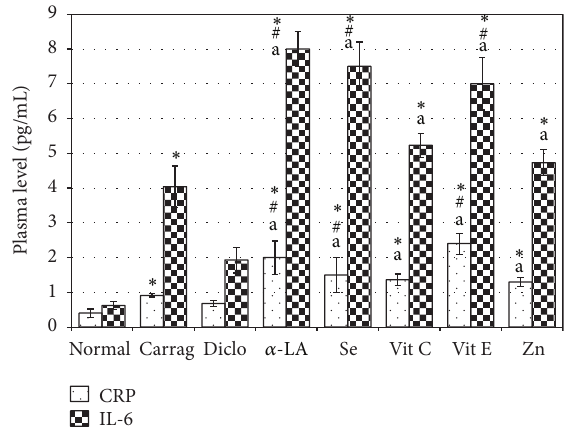
Figure 1: Effect of treatments on plasma CRP and IL-6 levels.All rats were provided daily oral doses of diclofenac (5 mg/kg), selenite (2.5 mg/kg), Vit C (1g/kg), Vit E (300mg/kg), or ZnSO 4 (25 mg/kg); 𝛼 -LA (50 mg/kg) was administered IP. ∗ # Value is significantly dif- ferent from normal control and carrageenan-only rats, respectively ( 𝑃 < 0.05 ). a Value is significantly different from that of diclofenac- treated hosts ( 𝑃 < 0.05